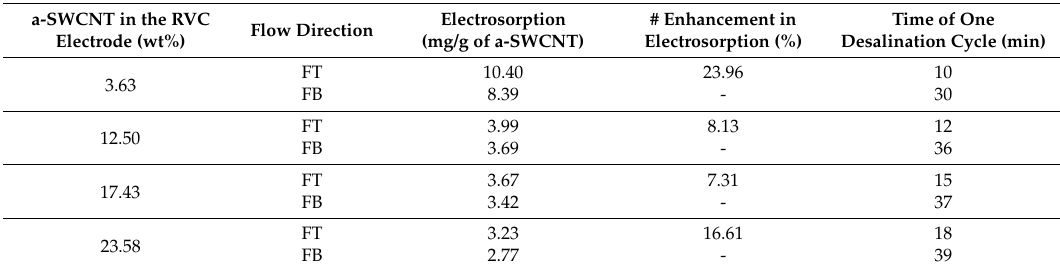
Table 4. Electrosorption capacities and the time of one desalination cycle of various a-SWCNT-coated RVC electrodes obtained by comparing the performance between flow feed-between (FB) electrodes and flow feed-through (FT) electrodes with the NaCl feed solution (75 mg/L). a-SWCNT in the RVC Electrode (wt%)